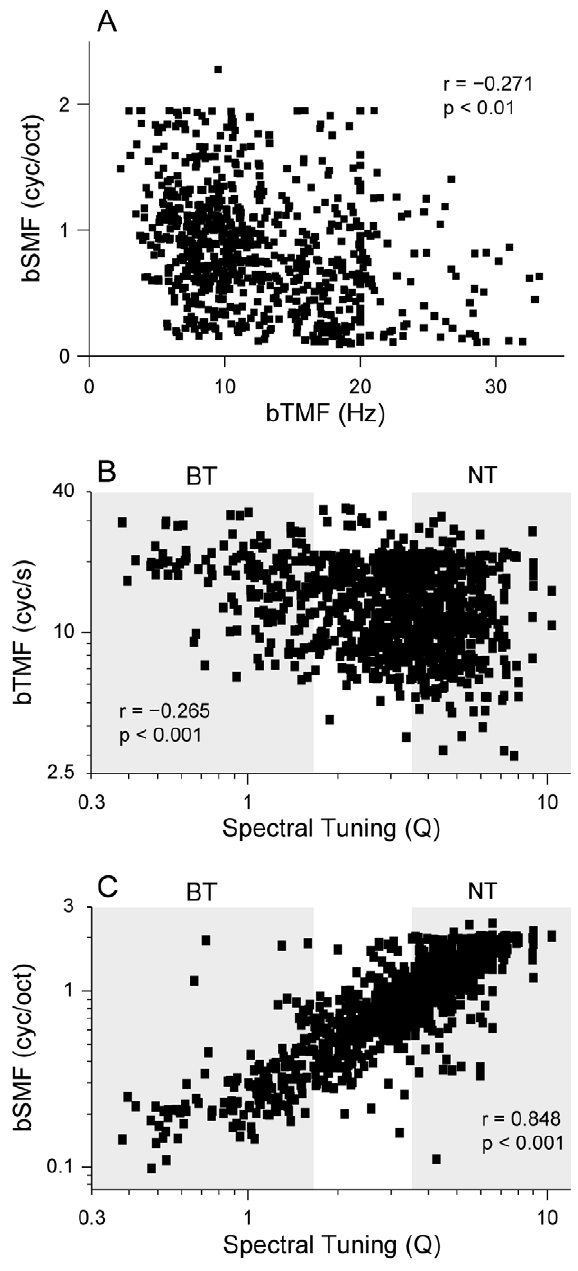
Figure 7. Best modulation frequency. (A) Best spectral modulation frequency (bSMF) versus best temporal modulation frequency (bTMF). bSMF is weakly correlated with bTMF (r= 2 0.271, p , 0.01, t-test). (B) bTMFs decrease as tuning sharpness increases (p= 2 0.265, p , 0.001, t- test). (C) bSMF is highly correlated with spectral tuning (r=0.848, p , 0.001, t-test). Shaded areas in (B,C) indicate Broadly Tuned (BT) and Narrowly Tuned (NT) neurons.